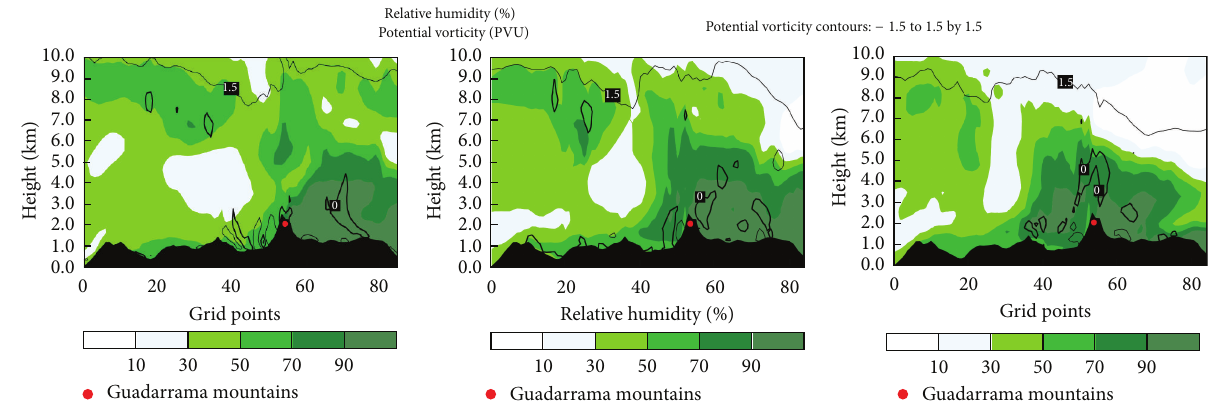
Figure 10: Cross section of relative humidity and potential vorticity in domain D02.